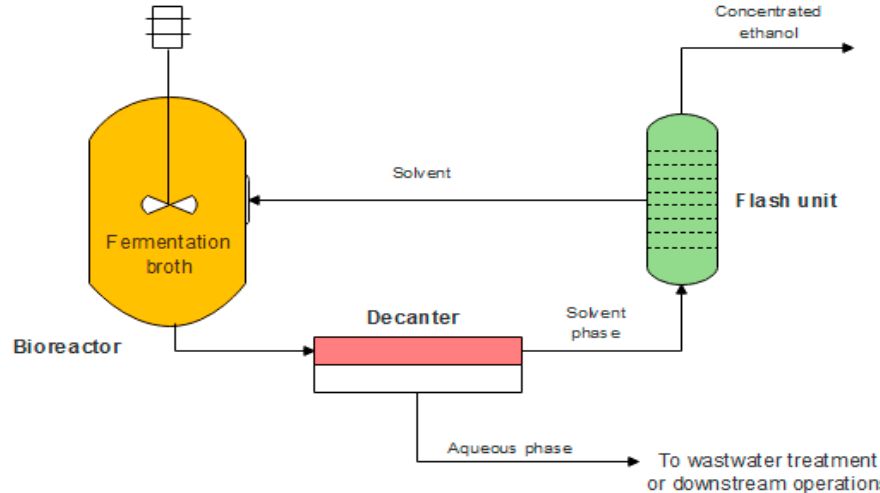
Figure 6. Simplified schema of the alcoholic fermentation process coupled with ethanol recovery system using solvent extraction.